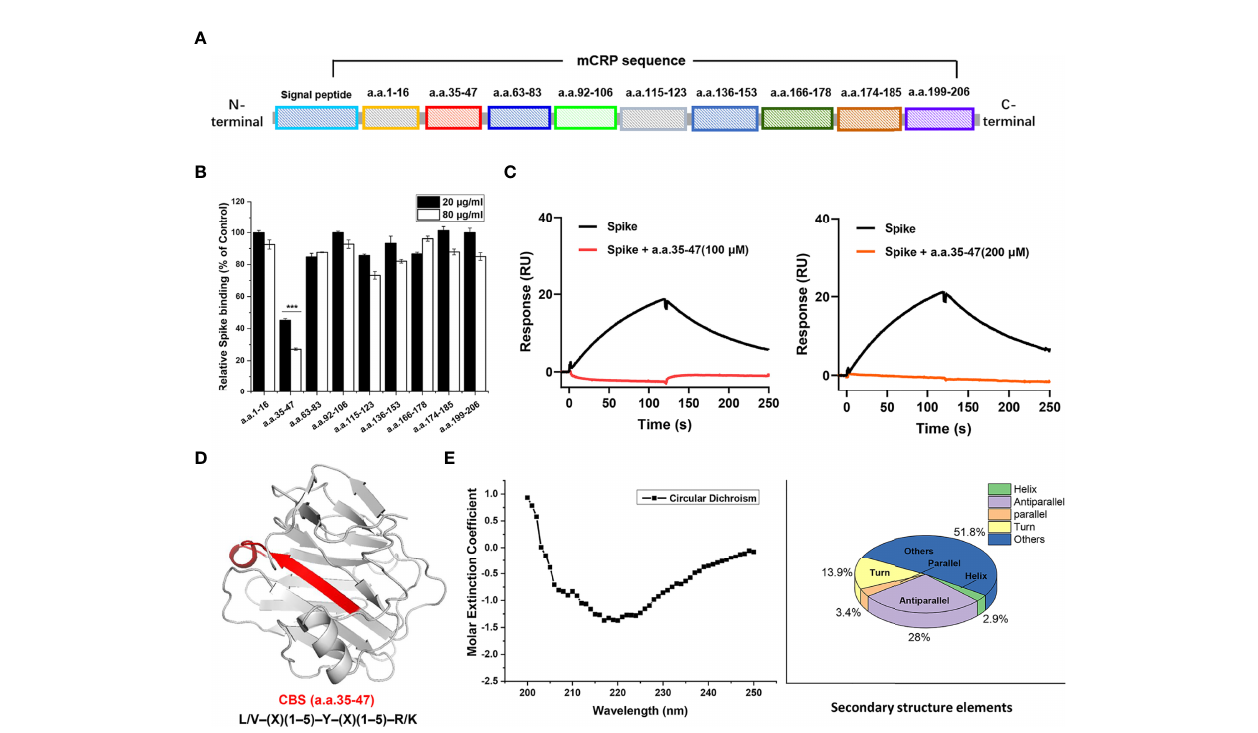
FIGURE 3 | The 35-47 amino acid motif of cholesterol-binding sequence (CBS) mediates the binding of mCRP to the spike RBD. (A) Schematic showing the screening for the motif that mediates the binding of mCRP to the spike RBD. Full-length mCRP was truncated and peptides were synthesized. (B) Competitive inhibition assay to assess mCRP binding to the spike RBD using mCRP-derived synthetic peptides. In the peptide competition assay, amino acids 35-47 signi fi cantly inhibited the binding of mCRP to the spike RBD, whereas other sequences did not (n = 3). (C) Competitive inhibition assay to assess the binding of different concentrations of amino acids 35-47 mCRP to the spike RBD detected using SPR. The results showed that amino acids 35-47 signi fi cantly inhibited the binding of mCRP to the spike RBD. (D) Schematic representation of amino acids 35-47 in the crystal structure of mCRP. This sequence is consistent with the features of the CBS consensus harboring the L/V – (X)(1 – 5) – Y – (X)(1 – 5) – R/K motif. (E) The secondary structure of amino acids 35-47 in solution was detected using circular dichroism. All results are presented as means ±